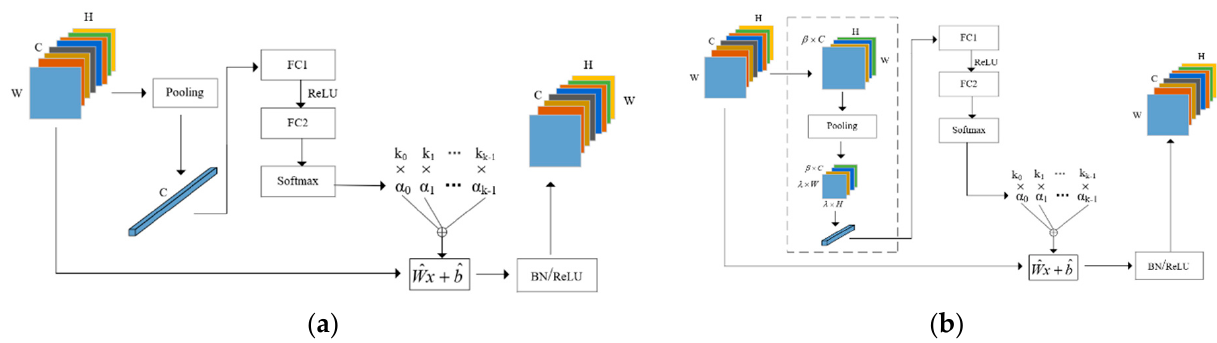
Figure 4. ( a ) Model diagram of the dynamic neural networks (DyNet) in which the size of the output from the pooling layer is C × 1 × 1, ( b ) model diagram of EAM-DyNet. Our method first selects representative spatial information, then uses adaptive pooling to compress the spatial information, k i is kernel i in Equation